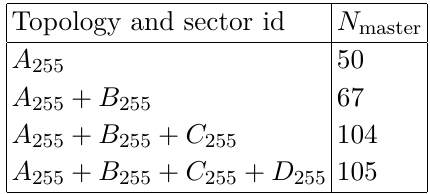
Table 1 . The number of master integrals. The table gives the cumulative sum, as for example topology B contains master integrals common to topology A and B